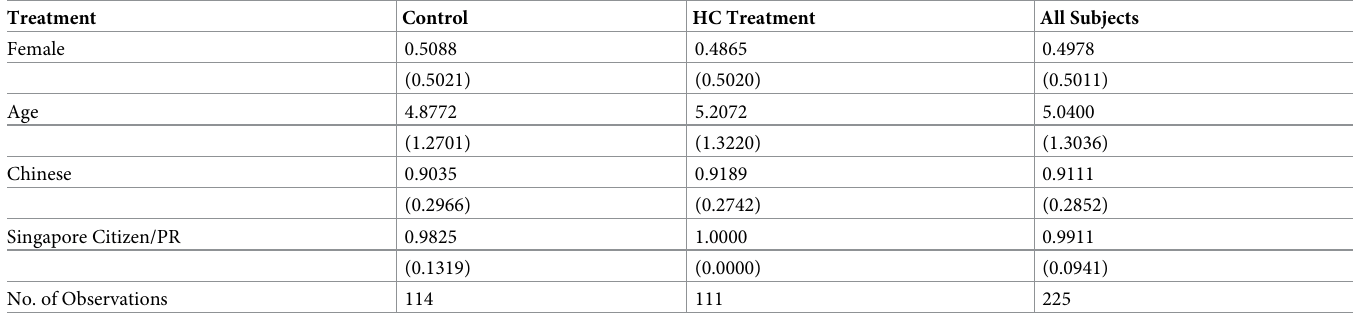
Table 1. Summary